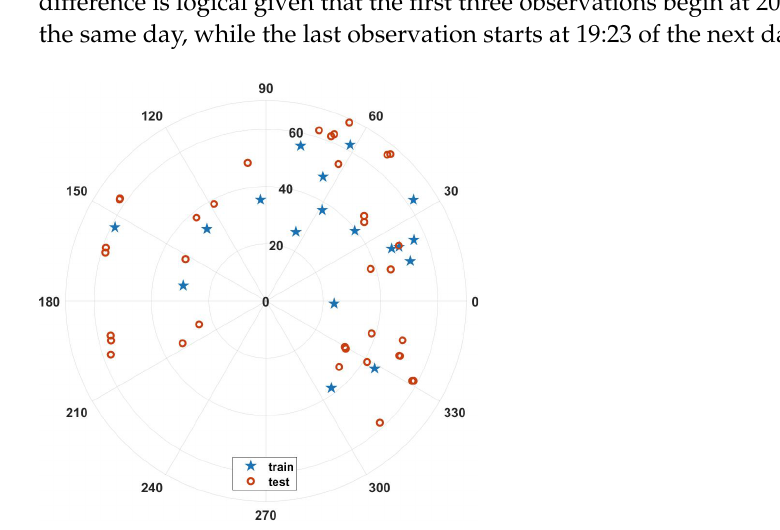
Figure 9. Star map distribution of the experiment.